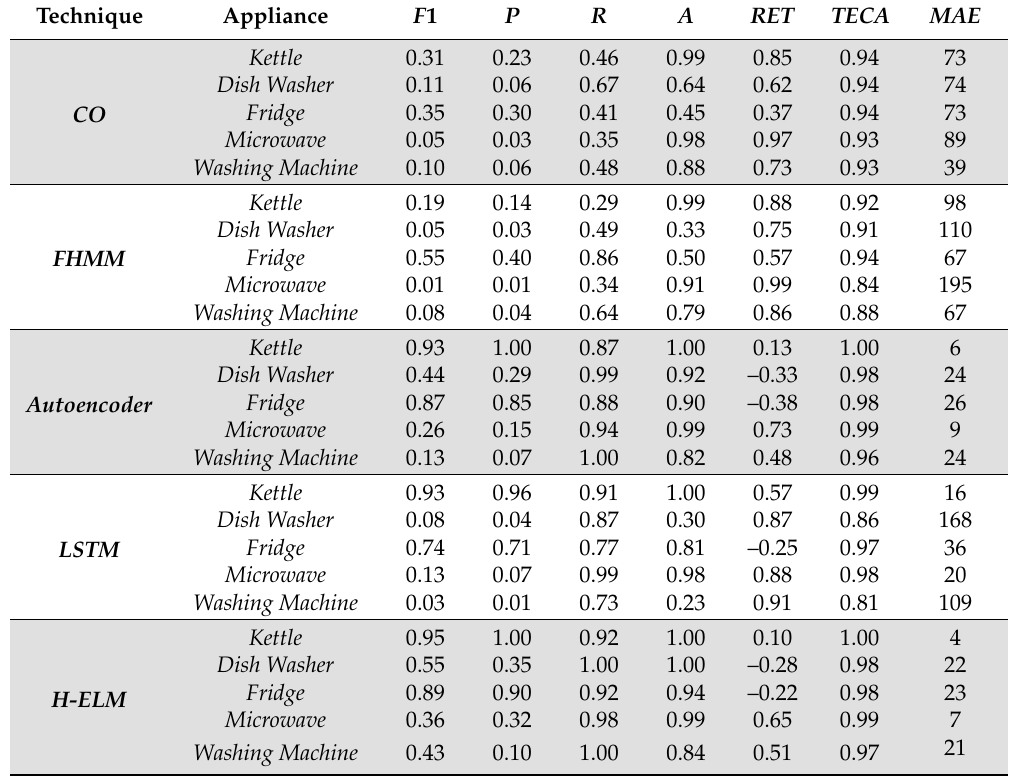
Table 4. Disaggregation performance for unseen houses during training. This evaluation is essential to assess the generalization capability of the pattern recognition